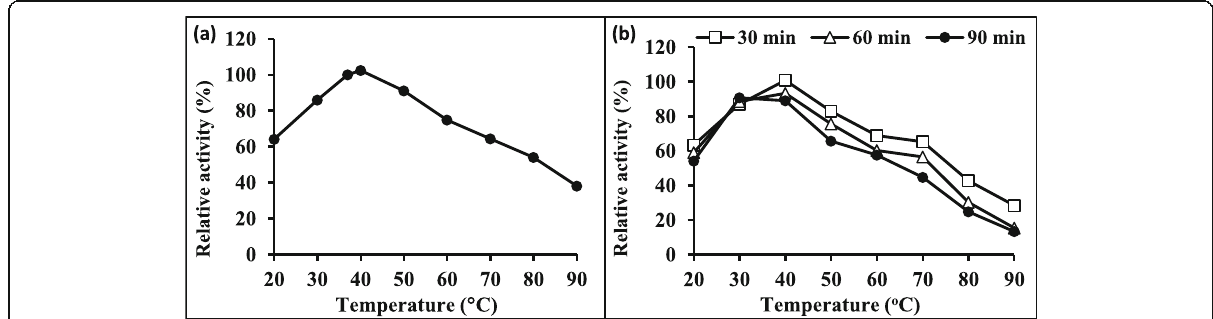
Fig. 4 Effect of temperature ( a ) and stability ( b ) on the lipase activity produced by R. oryzae R1. Initial activity (100%) = 205 U/mL at 37°C